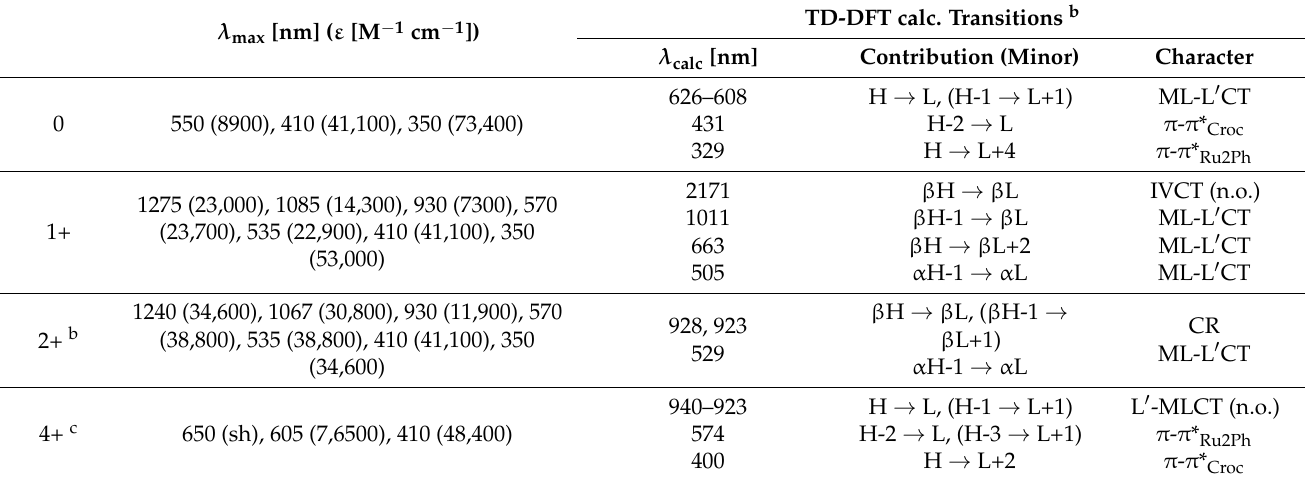
Figure 8. Charge densities on different constituents of 2 Ru 2 Ph-Croc in its neutral, monocationic, dicationic, and tetracationic states according to NBO analysis ( top ) and contour plot of the β-LUSO of the monocation ( bottom left ), the dication ( bottom middle ) and of the LUMO in the tetracation ( bottom right ). The notations top , bottom , left, and right correspond to the complex entities as they are depicted in the bottom panel. Table 3. UV/Vis/NIR data of the complexes in their various oxidation states a